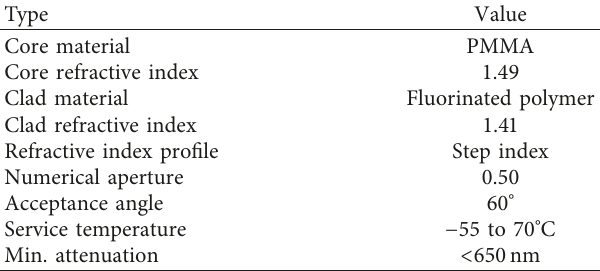
Table 1: Overall specification of POF specimens.